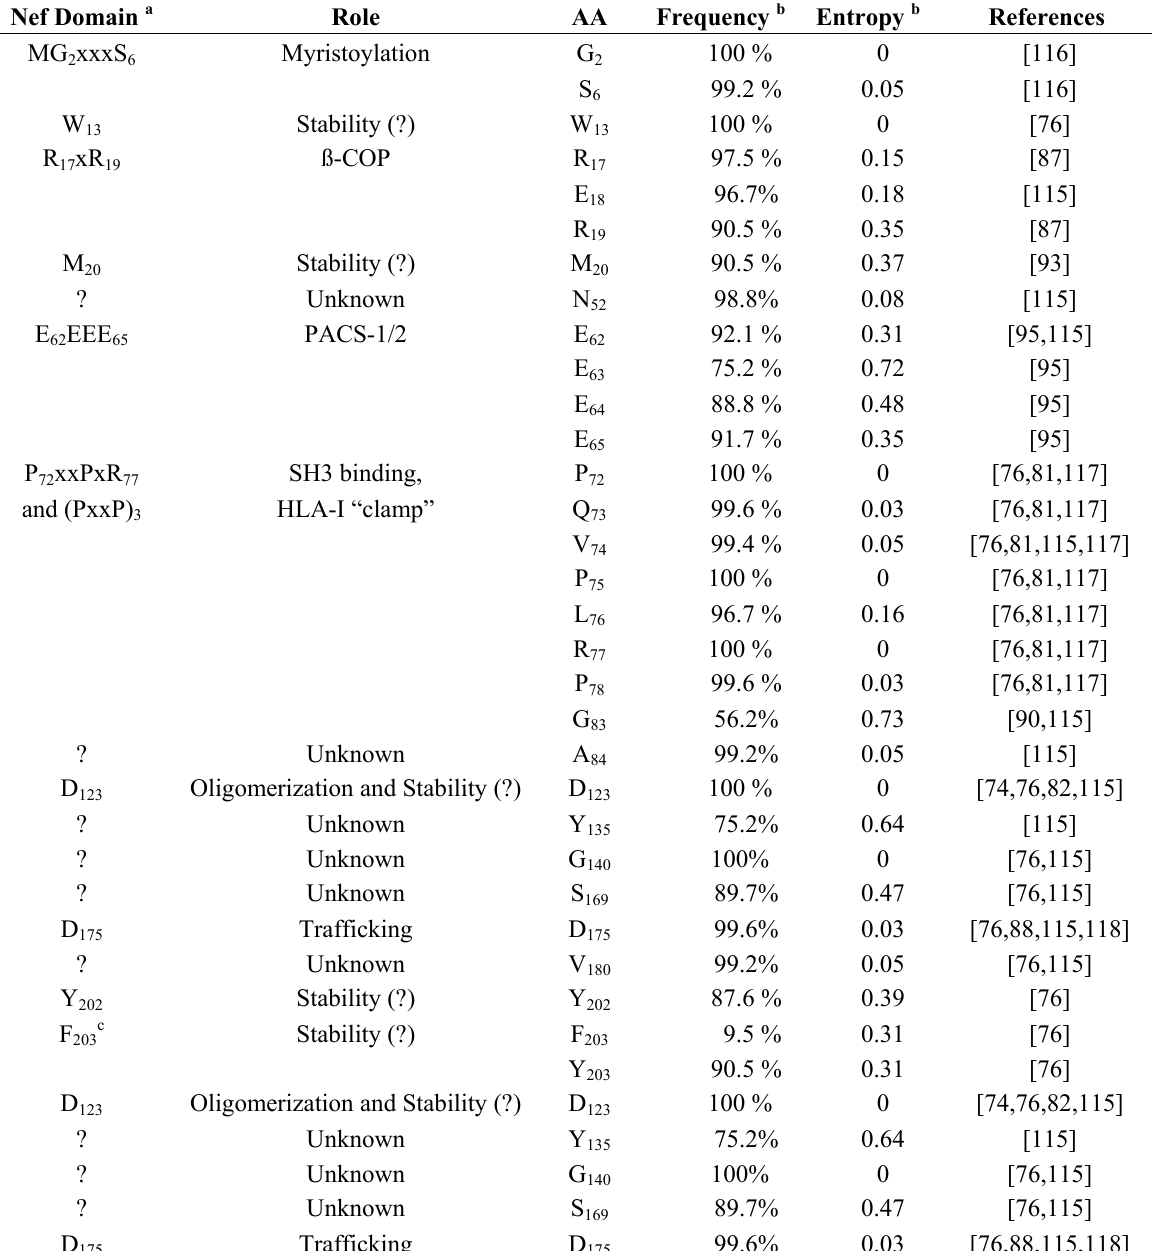
Table 1. Sequence conservation in HIV-1 negative factor (Nef) motifs required for HLA-I down-regulation.